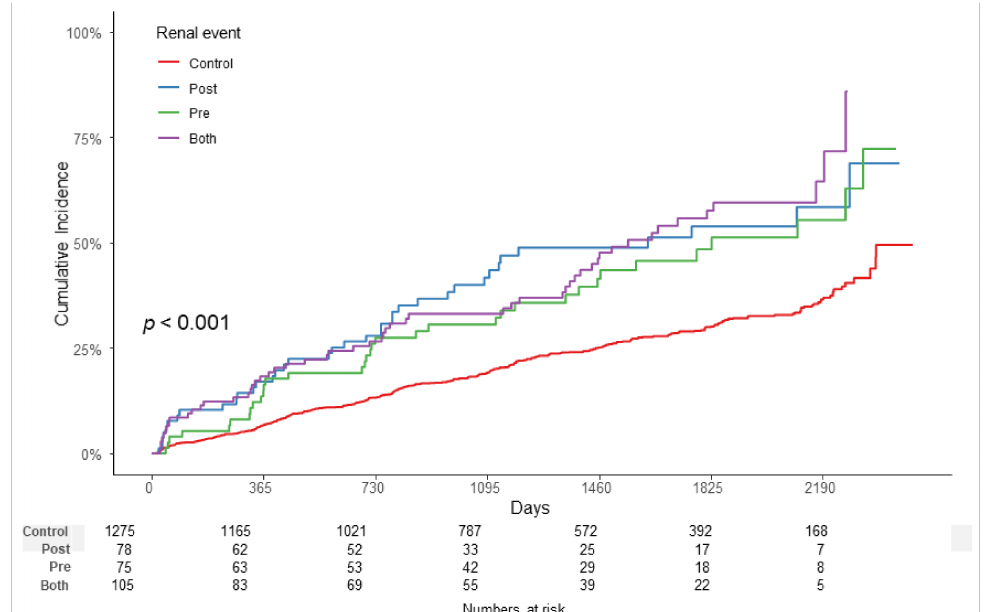
Figure 2. Kaplan–Meier survival curve with log-rank test between the ATRH subgroups. End-point renal outcome occurred more frequently in the ATRH group than in the control group, and among them, the most frequent occurrences were in the BOTH group than in the PRE group and POST group ( p < 0.001). Abbreviations: ATRH, apparent treatment- resistant hypertension.